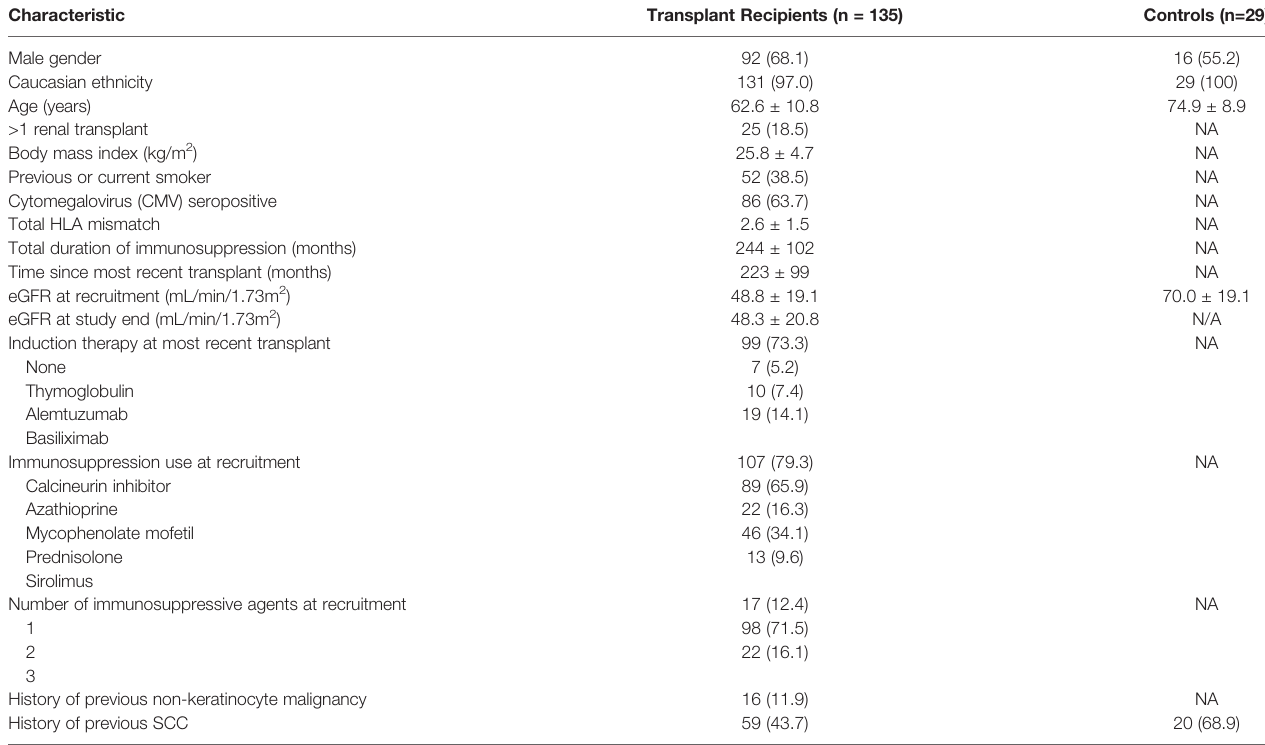
TABLE 1 | Cohort characteristics at